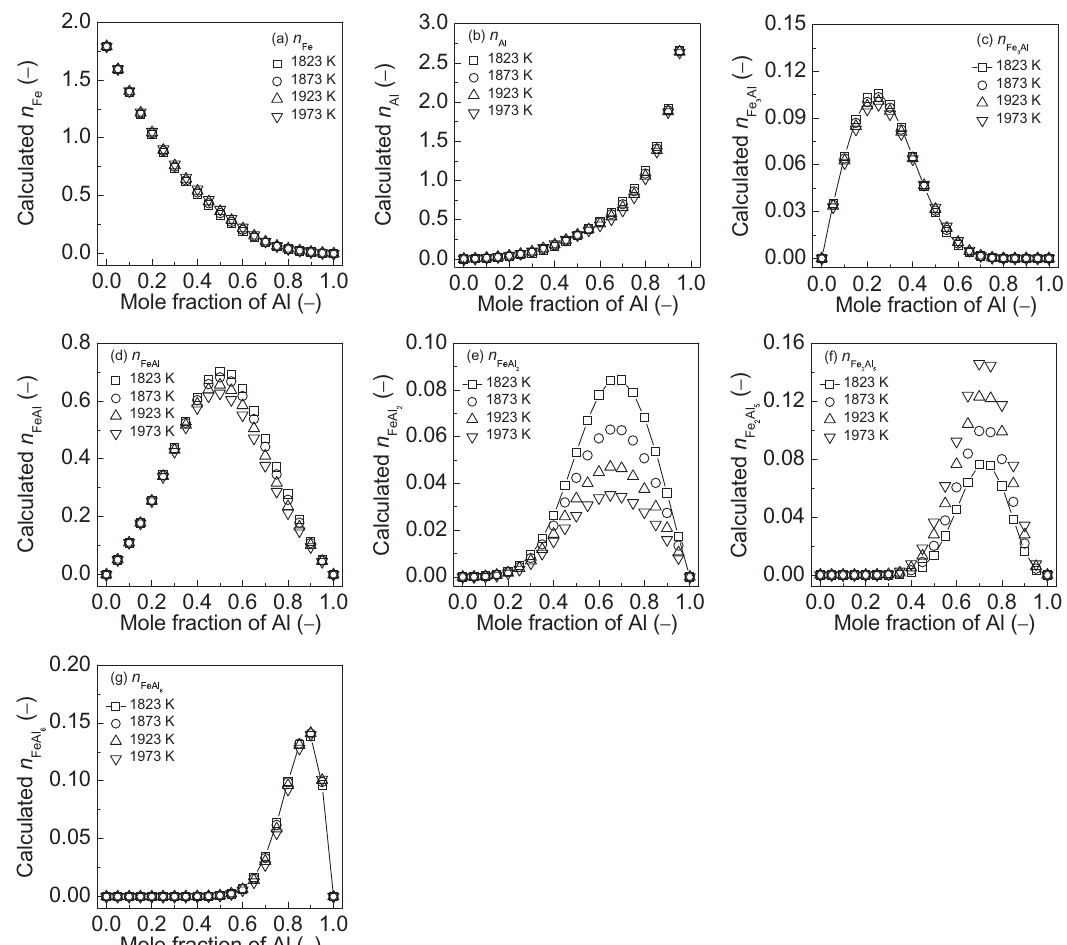
Figure 17: Relationship between mole fraction x Al of Al and calculated equilibrium mole number n i for seven structural units as Fe (a), Al (b), Fe 3 Al (c), FeAl (d), FeAl 2 (e), Fe 2 Al 5 (f), and FeAl 6 (g) in full composition range of Fe – Al binary melts at four temperatures of 1823, 1873, 1923, and 1973 K (1550, 1600, 1650, and 1700°C),